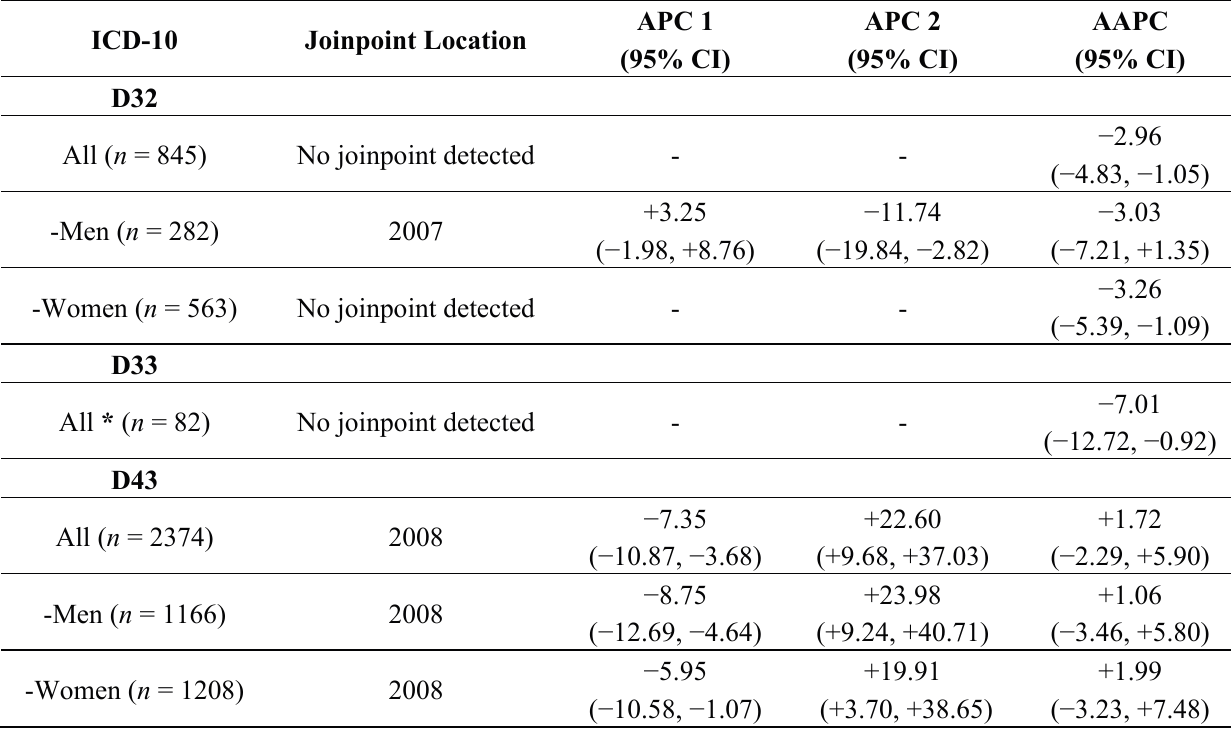
Table 2. Joinpoint regression analysis of trends in age-standardized death rates per 100,000 in the Swedish Causes of Death Register (CDR) 1998–2013